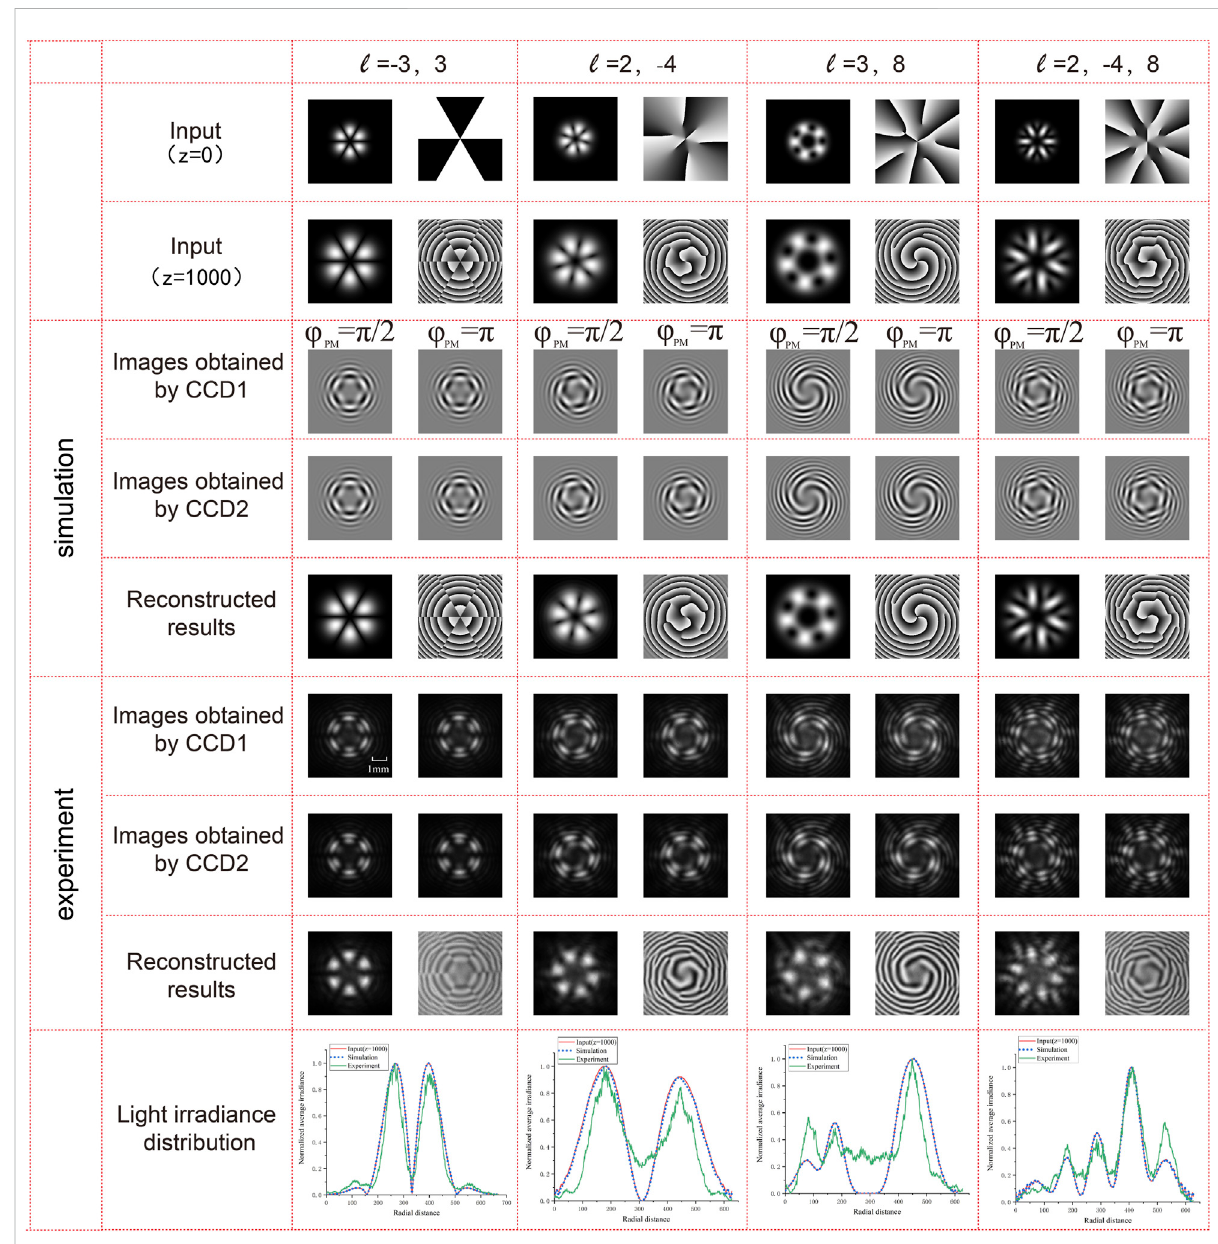
FIGURE 4 Simulation and experimental results of the proposed scheme to capture the amplitude and phase pro fi le of OAM superposition beam E in .